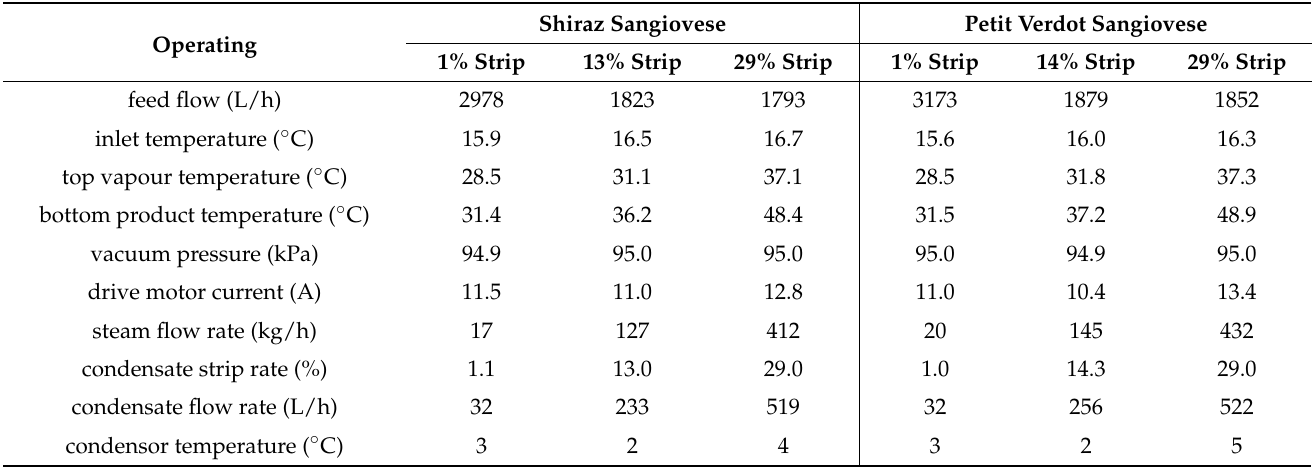
Table 4. System operating conditions during industrial scale spinning cone column distillation treatment of smoke-tainted Shiraz Sangiovese and Petit Verdot Sangiovese